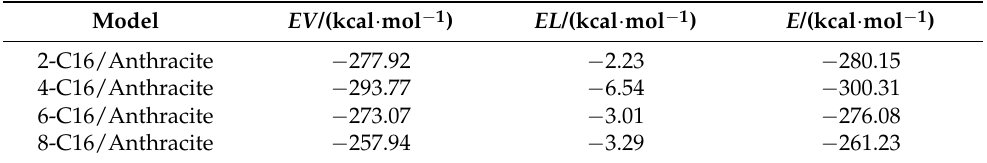
Table 2. Interaction energy between the surfactant and